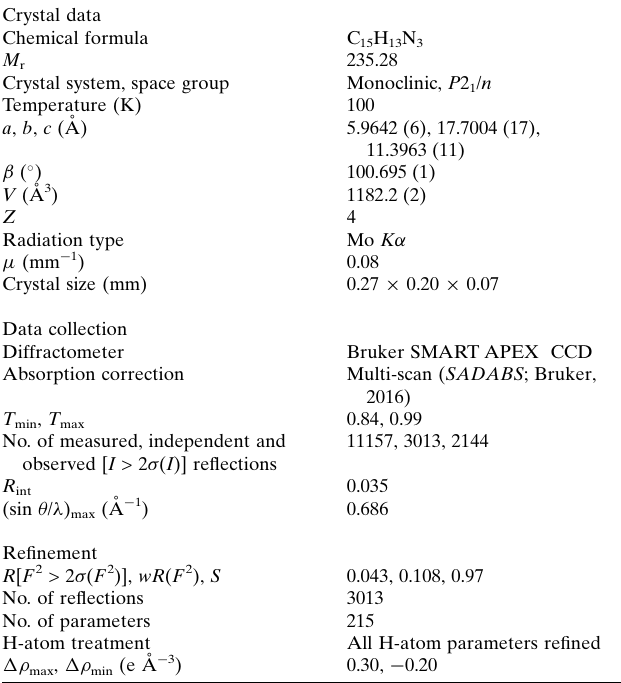
Table 2 Experimental details.